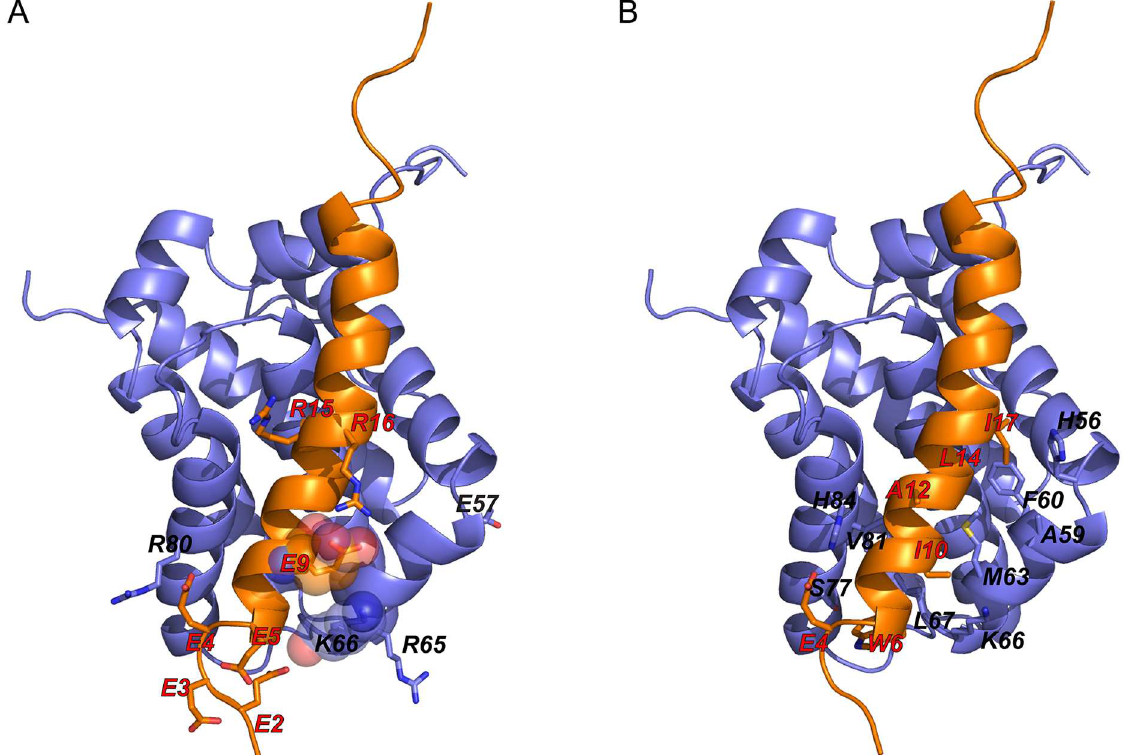
Fig 6. Critical residues within the encounter complex. Residuesfor opposite-charged(A) and vdw interactions(B) frequently observedwithin the encounter complex(probabilityover 0.1) at low ionic strength (10 mM). The one native opposite-charged contact pair with high probabilityis shown with spheres. Mcl-1 residues are labeledin black; PUMA residues are labeledin